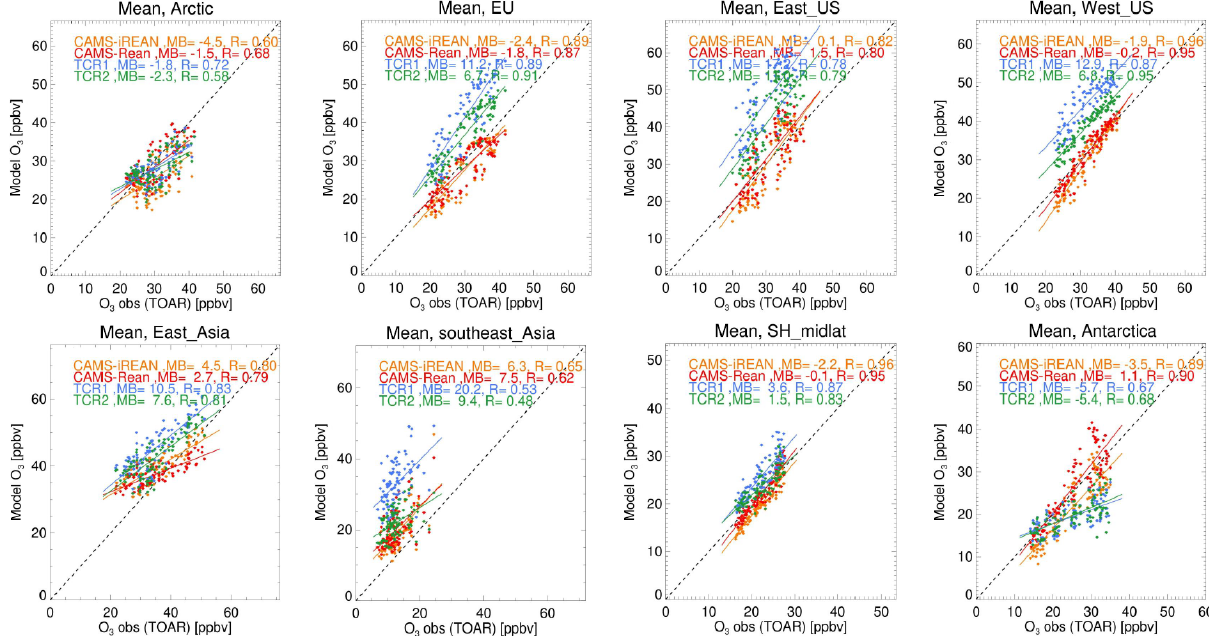
Figure 8. Scatter plot of surface ozone against TOAR observations for the 2005–2012 regionally averaged monthly-mean time series. The mean bias and temporal correlation are also